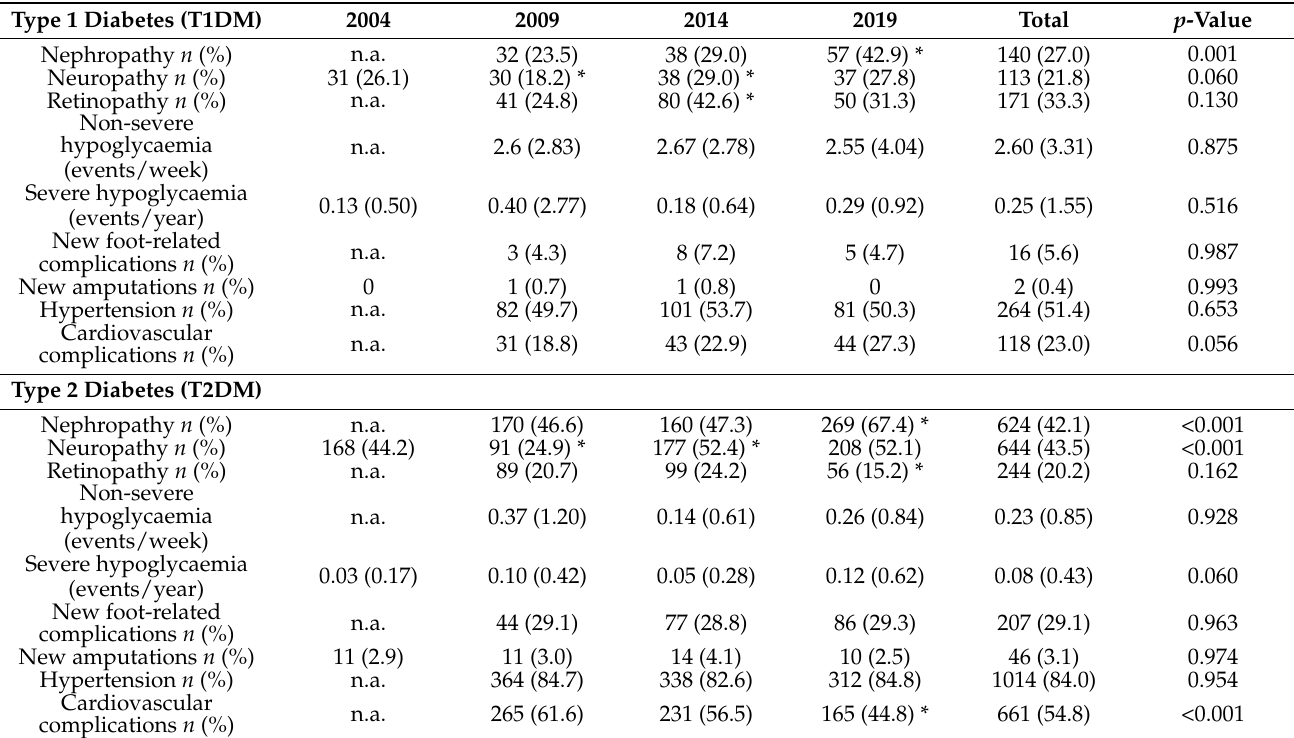
Table 4. Diabetic complications and comorbidity of patients in tertiary care